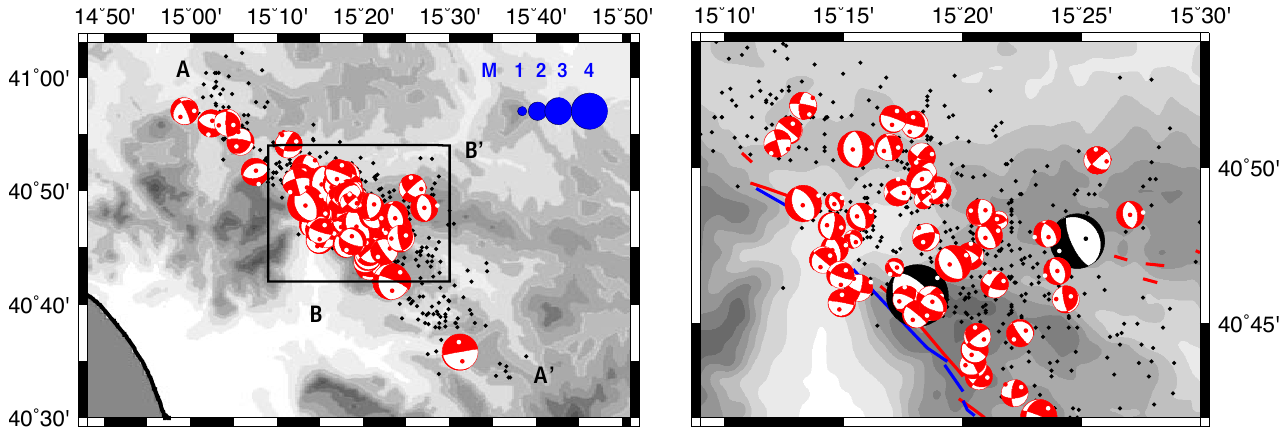
Figure 3. Maps of the study area. Left panel: Fault plane solutions obtained by selecting 80 aftershocks recorded at more than 15 stations. The sizes of the focal spheres are proportional to the magnitudes of the event (see blue balls scale). Rectangle, area shown in the right panel. AA’ and BB’, vertical sections reported in Figure 4a, b. Right panel: Fault plane solutions obtained by selecting aftershocks recorded at more than 15 stations (red beach balls) and the focal mechanisms of the F1 and F3 events (black beach balls) [Amoruso et al. 2005a]. Blue thick solid lines, fault scarps identified by Pantosti and Valensise [1990]; red thick solid lines, fault scarps identified by Blumetti et al.